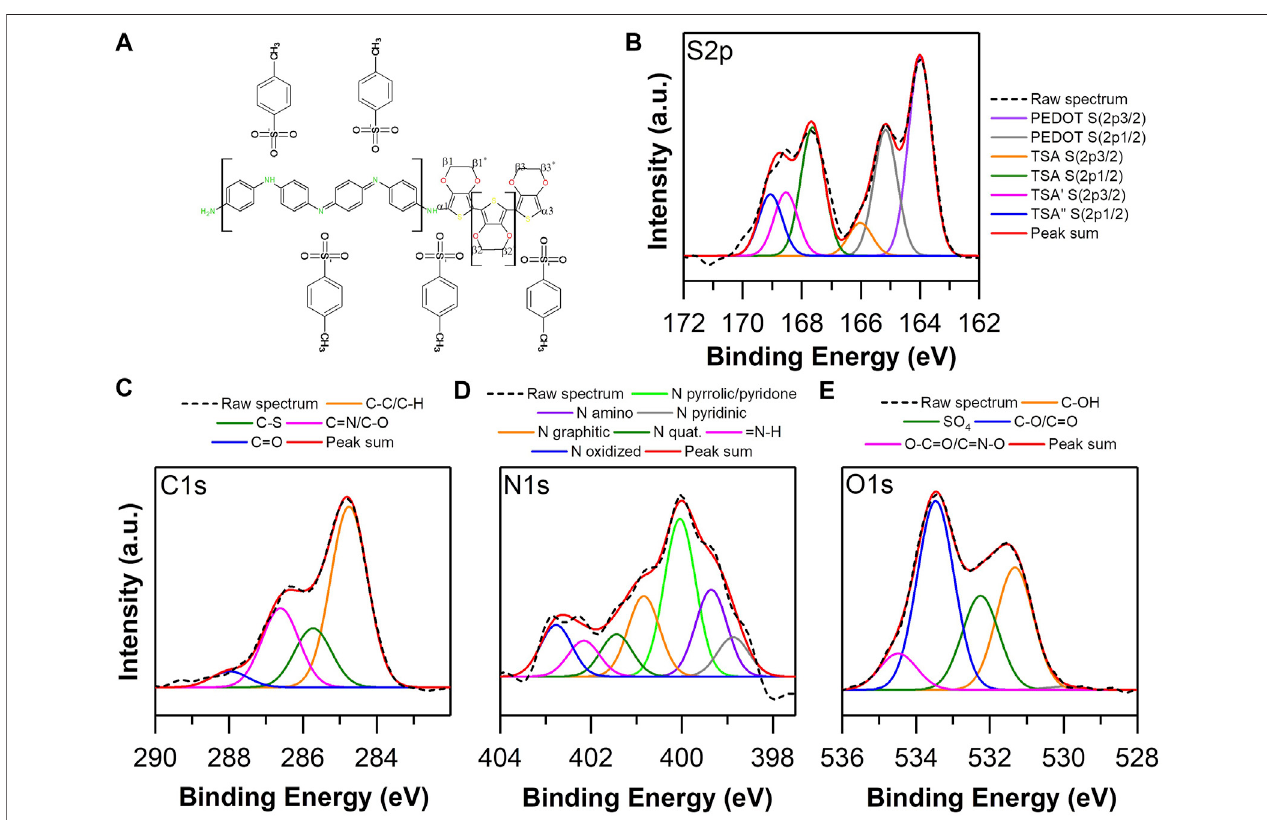
FIGURE 9 | (A) Proposed structure of EDOT-ANI TSA Copolymer. High Resolution XPS Spectra of EDOT-ANI 0.7 – 0.3 TSA: (B) S 2p, (C) C 1s, (D) N 1s and (E) O 1s.